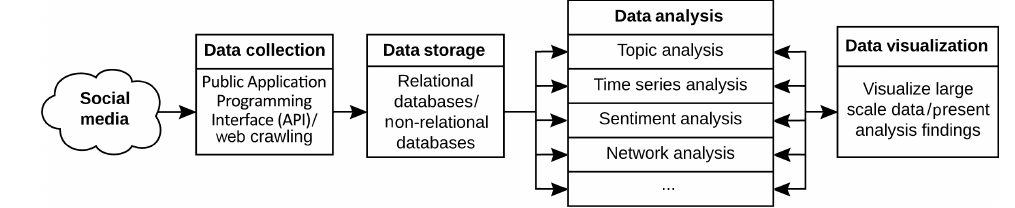
Fig. 5 Common application